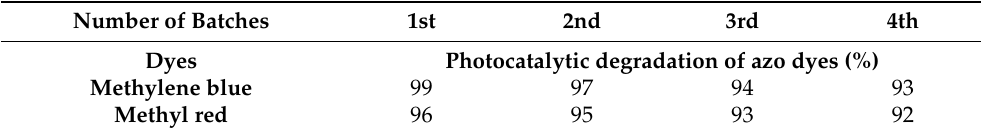
Table 3. Reusability of CS-NM bio-composite for the two selected dyes under optimum conditions,